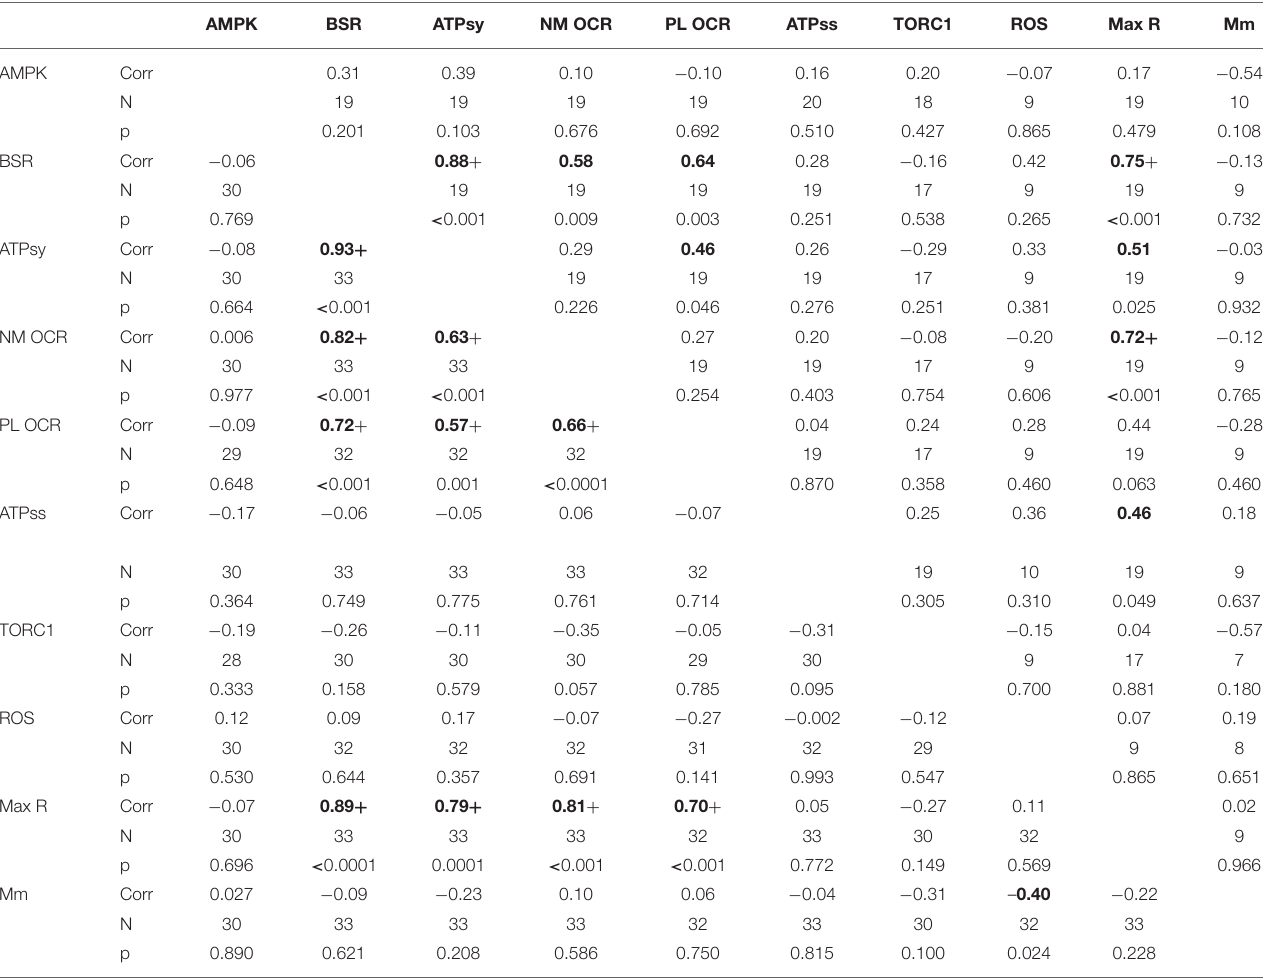
TABLE 2 | Spearman’s rank correlations among biochemical variables for controls (lower triangle) and FXTAS (upper